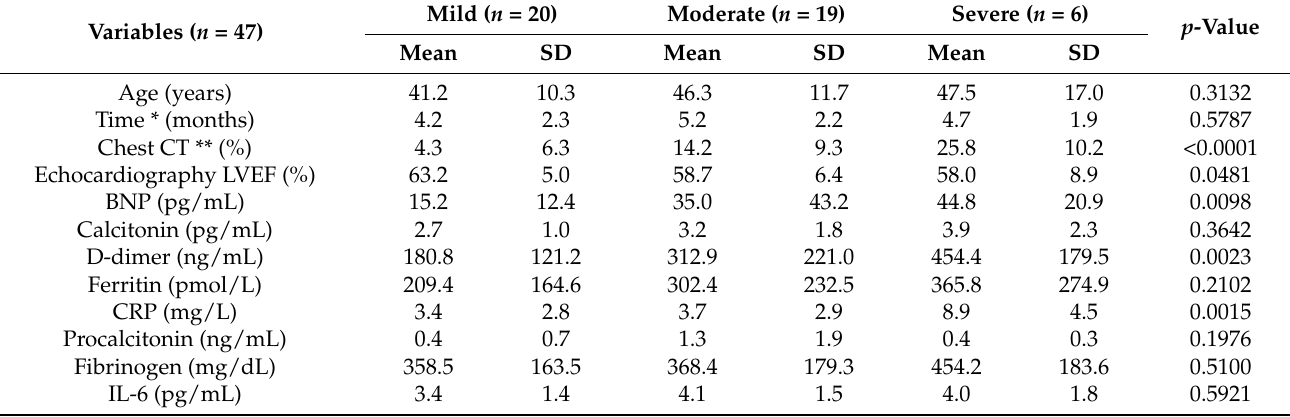
Table 3. Descriptive statistics of the case group by disease severity (COVID-19).